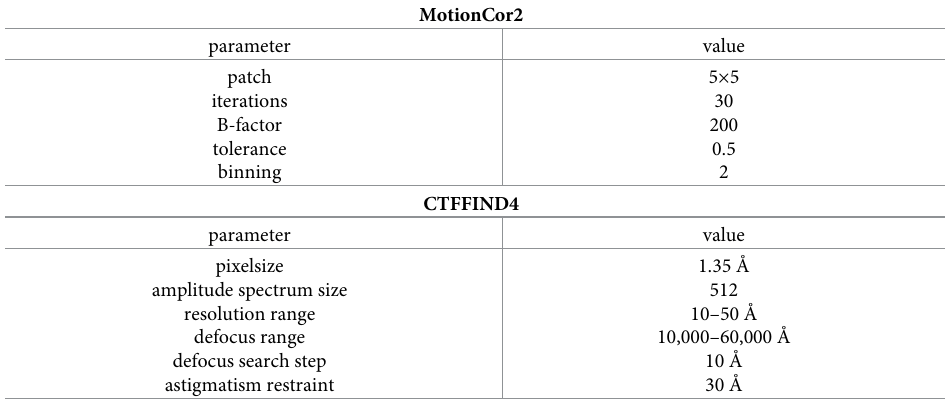
Table 2. Preprocessing parameters. Parameters used in MotionCor2 and